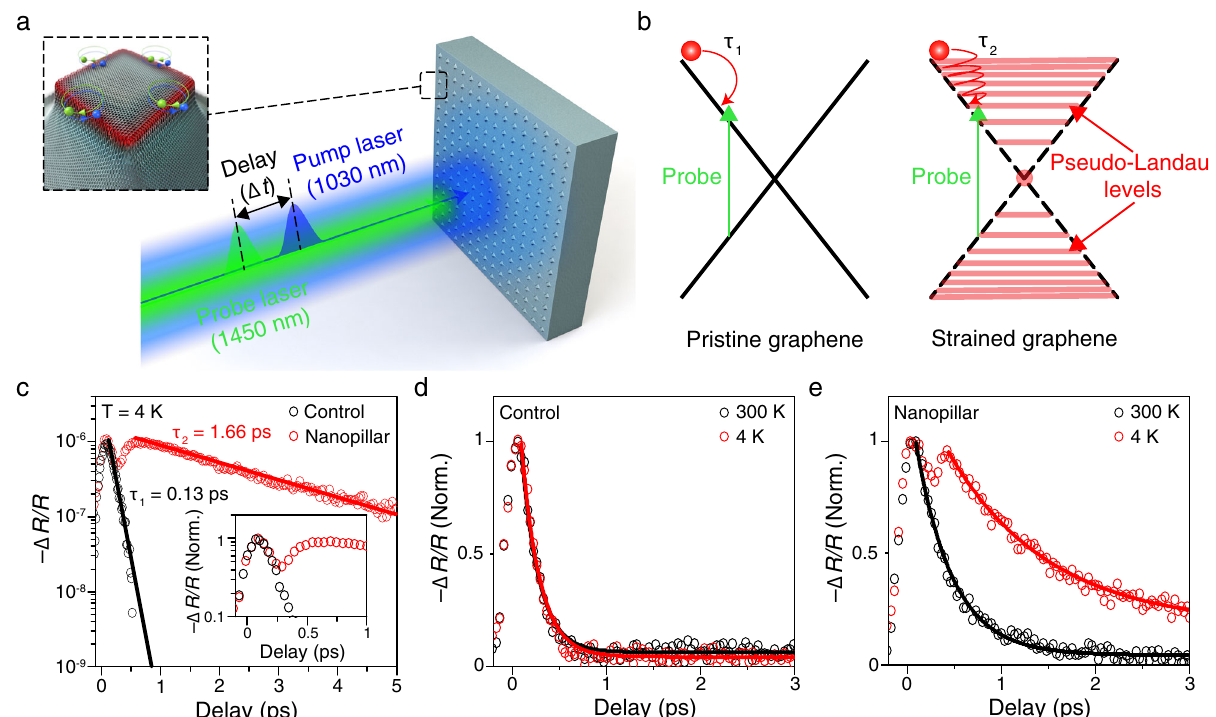
Fig. 3 Pseudo-magnetic fi eld-induced ultra-slow carrier dynamics. a Schematic illustration of our femtosecond pump – probe measurement setup. Pump pulses (blue) excite charge carriers and probe pulses (green) are used to monitor the sample responses at different delay times ( Δ t ) after the pump pulses arrive at the sample. Left inset: magni fi ed image of a single nanopillar structure. b Schematic illustration of relaxation process of photoexcited carriers in pristine graphene with massless Dirac cones (left) and strained graphene attaining pseudo-Landau levels (right). The formation of pseudo-Landau levels can signi fi cantly decelerate the relaxation process, resulting in a longer decay time in strained graphene ( τ 1 « τ 2 ). c Measured re fl ection change as a function of the delay time on control (black) and nanopillar (red) samples. Symbols are measurement data; lines are fi tting data for the decay region. The decay times of both samples are extracted from fi tting data; τ 1 = 0.13 ps (Control) and τ 2 = 1.66 ps (Nanopillar). Inset: Normalized re fl ection change of both samples from − 0.15 to 1 ps. d , e Normalized re fl ection change of control ( d ) and nanopillar ( e ) samples measured at 300 K (black) and 4 K (red). Symbols are measurement data; lines are fi tting data for the decay